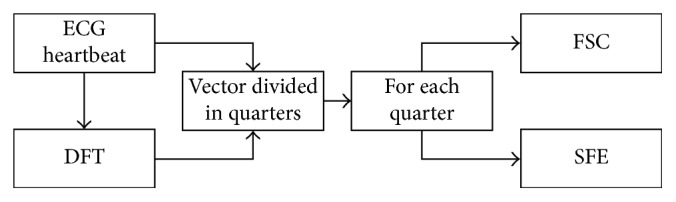
Feature extraction.